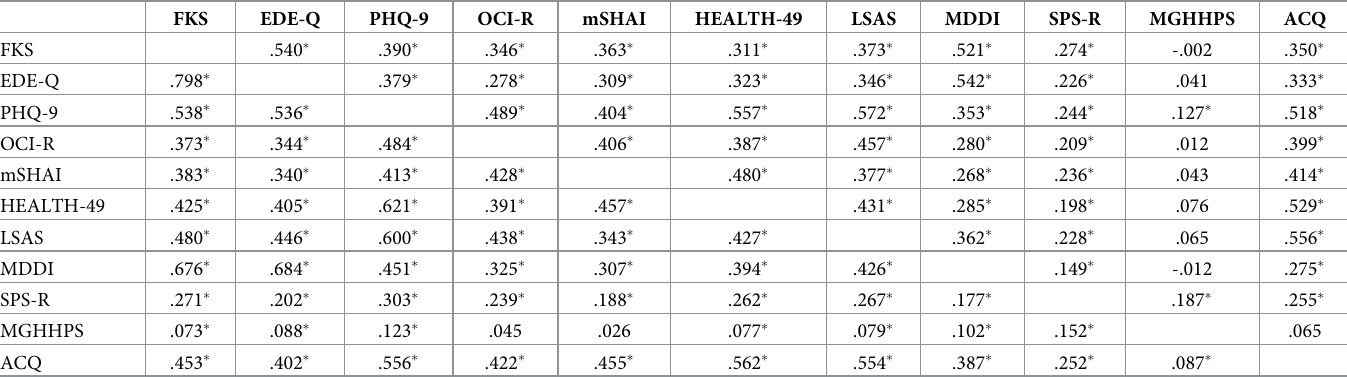
Table 2. Pearson correlations between symptom measures.